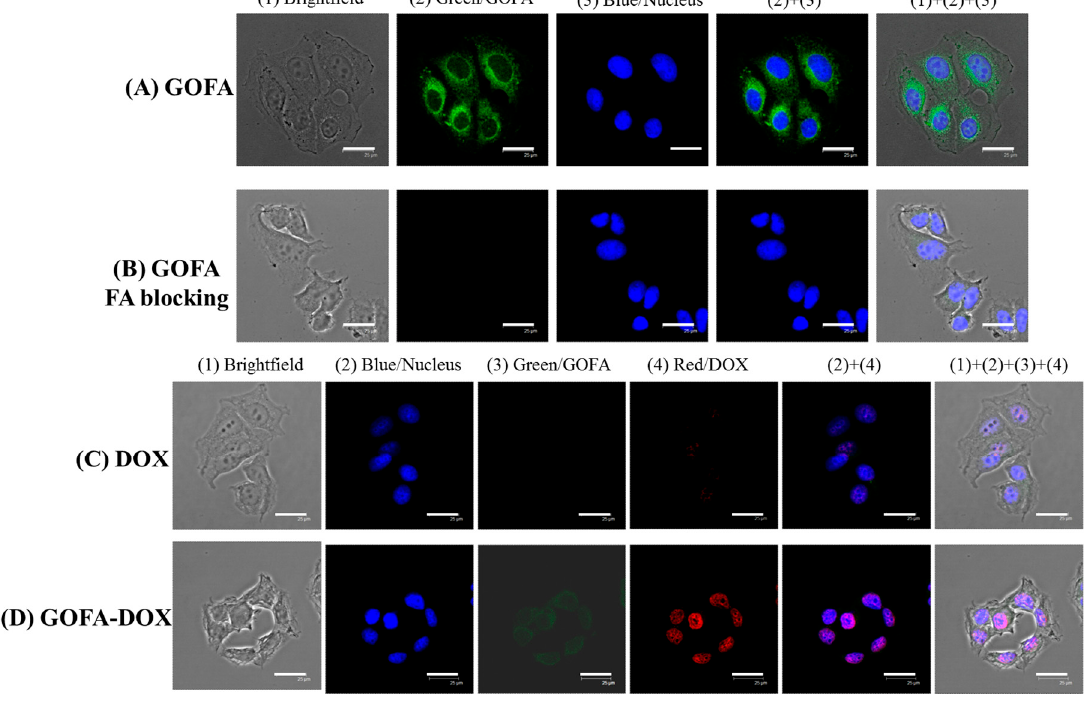
Figure 5. Confocal microscopy images of MCF-7 cells after incubated with GOFA for 1 h ( A ); incubated with 0.1 mg/mL folic acid for 1 h to block cell surface folate receptors and then treated with GOFA for 1 h ( B ); incubated with free DOX for 1 h ( C ); incubated with GOFA-DOX for 1 h ( D ). Bar = 25 μ m.